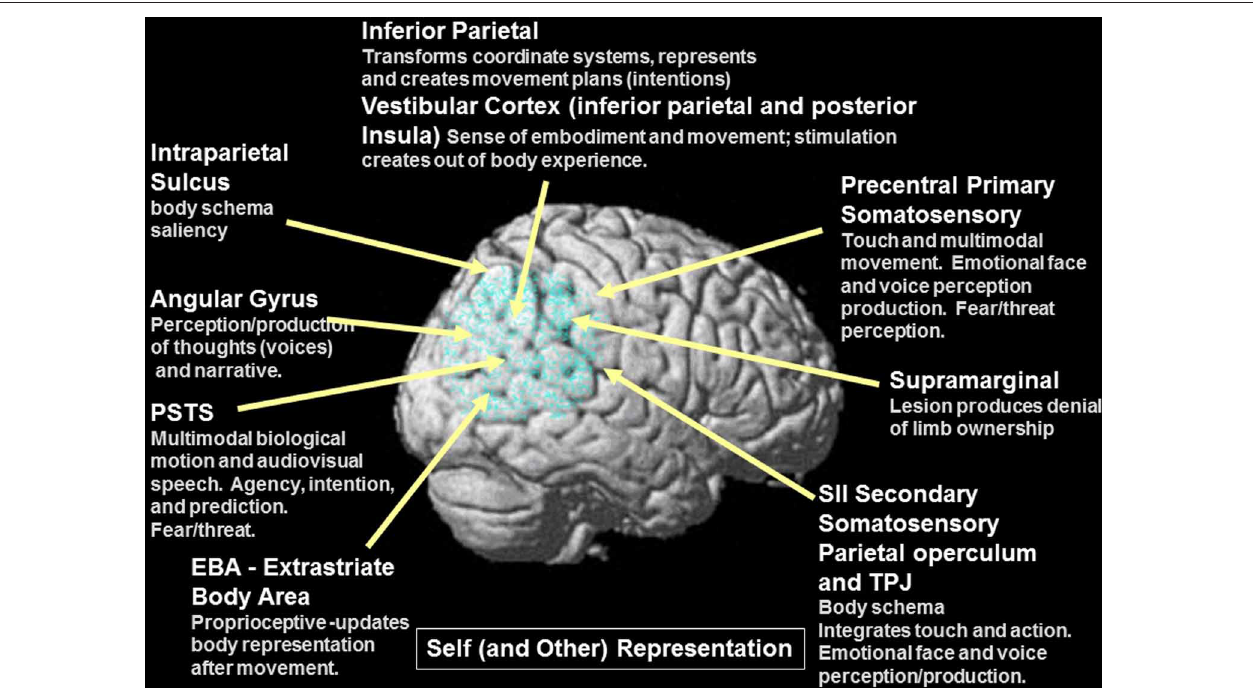
FIGURE 5 | Details of self representation and the overlap between self and other representation within the components of the system (gray font). Note the extensive overlap between elements of the